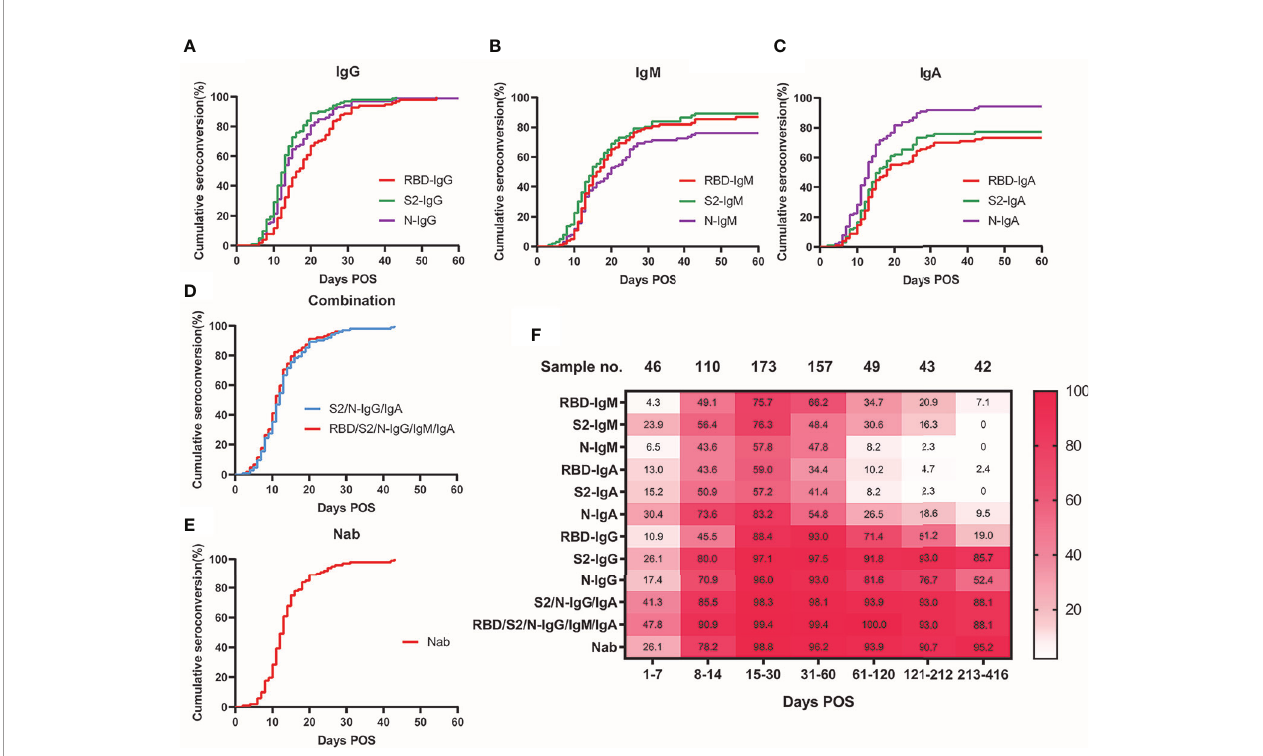
FIGURE 2 | Seroconversion rate of antibodies and Nab over time. Cumulative seroconversion curve of S1-RBD, S2-ECD, and N-speci fi c IgG (A) , (p = 0.0001), IgM (B) , (p = 0.0213), IgA (C) , (p < 0.0001). Days POS formed the x-axis and cumulative seroconversion rate formed the y-axis. The median seroconversion time (days) for antibodies targeting S1-RBD, S2-ECD, and N, respectively: IgG: 17, 13, 13; IgM: 16, 15, 20; and IgA: 18, 16, 13. Final seroconversion rate (%) for antibodies targeting S1-RBD, S2-ECD, and N, respectively: IgG: 96.1, 99.0, 98.0; IgM: 83.3, 85.3, 73.5; and IgA: 70.6, 73.5, 93.1. (D) Cumulative seroconversion curve of combination of S2/N-IgG/IgA (blue) and RBD/S2/N-IgG/IgM/IgA (red), the median seroconversion time was 12 and 11 d respectively. (E) Cumulative seroconversion curve of neutralizing activity (Nab titers ≥ detection limits of 1:20). Median seroconversion time of Nab was 13 d, and the fi nal seroconversion rate was 99.0%. (F) Heatmap for visualization of the real-time positive rate of various speci fi c immunoglobulins and neutralizing activity over time POS. Different shades of color indicate different positive rates (the darker the color, the higher the positive rate). Numbers in the color-block are the real-time positive rates of the corresponding time and antibodies. ECD, extracellular domain; Ig, immunoglobulin; N, nucleocapsid protein; Nab, neutralizing antibodies; POS, post onset of symptoms; RBD, receptor-binding domain; S,